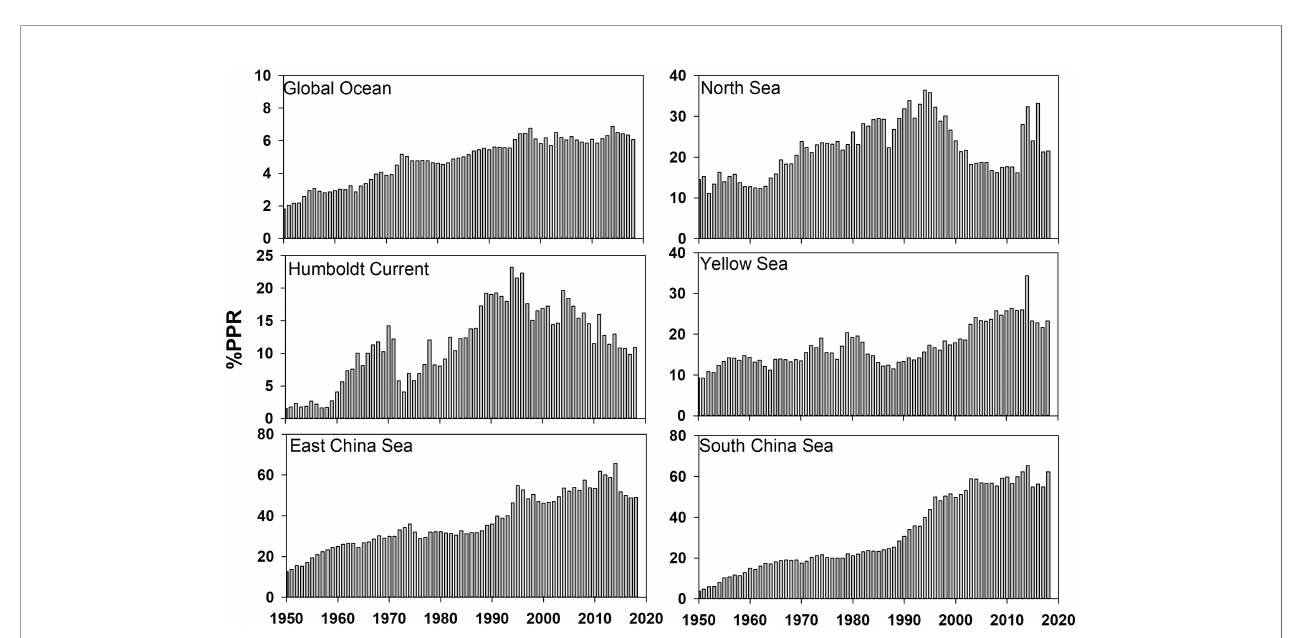
FIGURE 6 | The expansion factors in the global ocean and fi ve LMEs from 1950 to